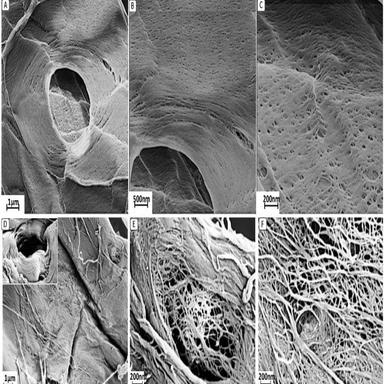
Various comparative HIM (aec) and SEM (dei) micrographs on eucalyptus never dried, critical point dried pulp: a) fiber surface that shows typical formation of fibrils throughout the surface, b,c) ultrastructure of the fiber surface at high magnification; d,g) fiber surface, the networking of nanofibrils shown; e,h) torn area of fiber, shows the internal structure of the fiber, f,i) fiber surface with some of the outer layer peeled off.